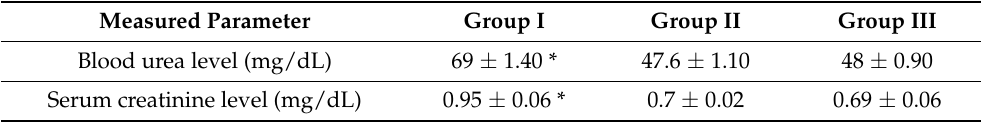
Table 3. Blood urea and serum creatinine levels in the tested groups.